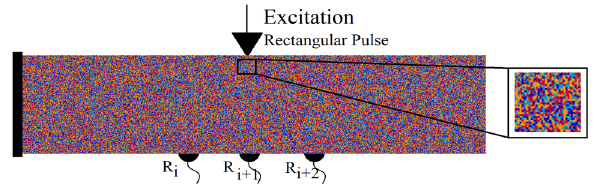
Figure 16. The randomly distributed heterogeneity inside the beam body to mimic a rock